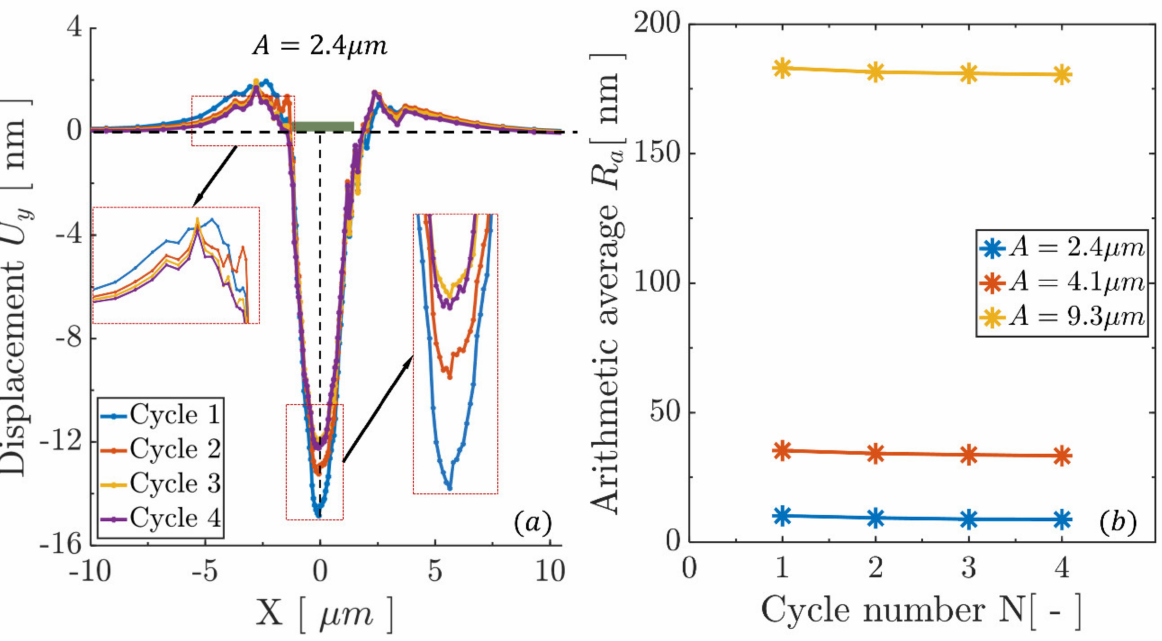
Figure 6. Preceding indentation effect on surface roughness evolution with cycles: ( a ) the surface profile under contact size A = 2.4 µ m, which was introduced by the preceding indentation with 4 cycles, ( b ) roughness evolution with cycles under the three contact